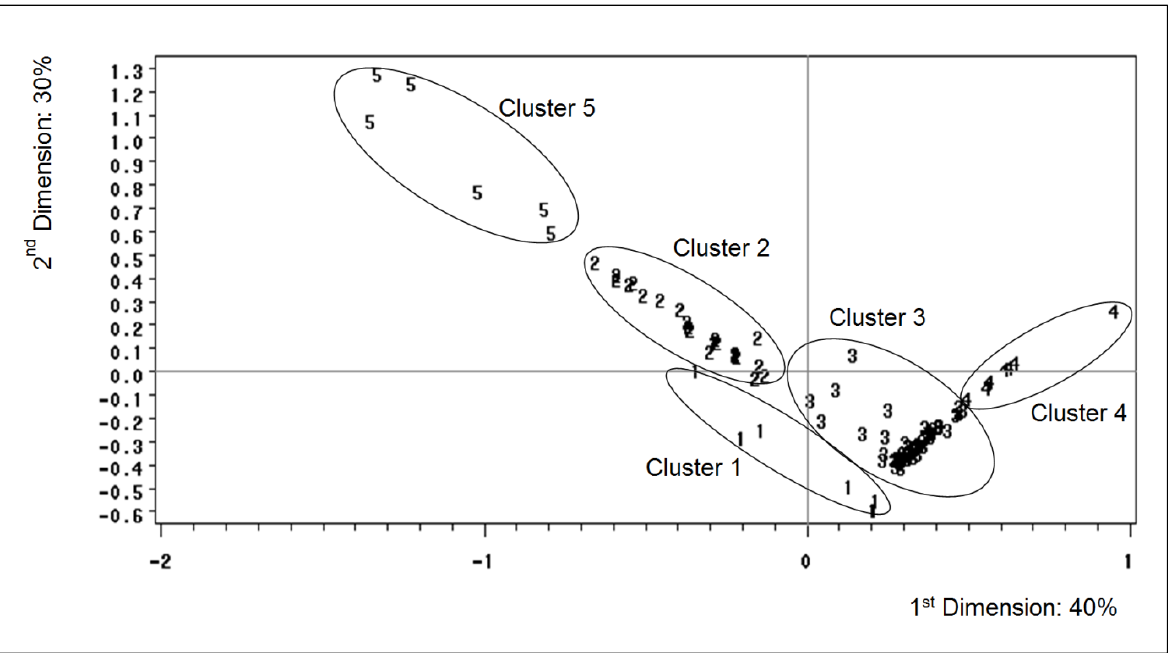
Figure 3. Distribution of the 102 Study Farms by Cluster, Presented Visually According to the Two First Dimensions of the Multiple Correspondence